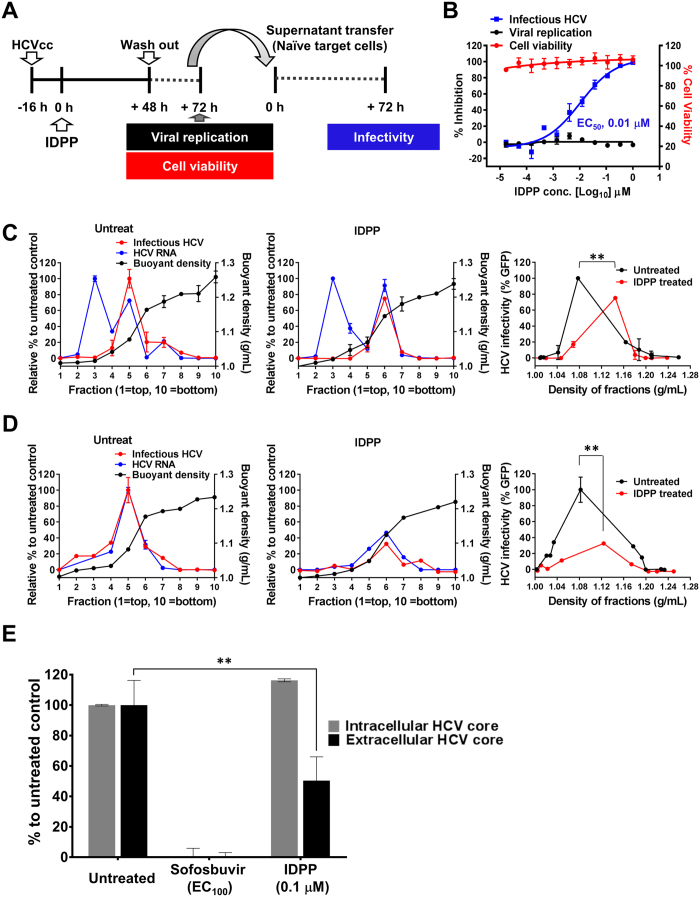
Inhibitory effect of IDPP on secretion of infectious HCVcc.(A) Schematic representation of the viral supernatant transfer experiment. Viral cell culture supernatants were transferred to naïve target cells and analyzed at 3 days post-infection. (B) Black circles, blue squares, and red circles indicate inhibition of viral replication, secretion of infectious HCV, and cell viability, respectively. Results are shown as the mean ± SD of two independent experiments in quadruplicate. Sucrose density gradient ultracentrifugation of cell lysates (C) and cell culture supernatants (D) obtained from transiently transfected HCV producer cells treated with IDPP or untreated (as described in supplement). Data represent relative HCV infectivity to DMSO (untreated control), HCV RNA levels, and buoyant density of each fraction. The mean value of two independent experiments is plotted and statistical significance of changes in HCV particle density calculated (**p < 0.01). (E) Total amounts of intra/extracellular HCV core in the transiently transfected cells were assessed by HCV core ELISA. Experiments conducted in duplicate and normalized to the untreated control. **p < 0.01.